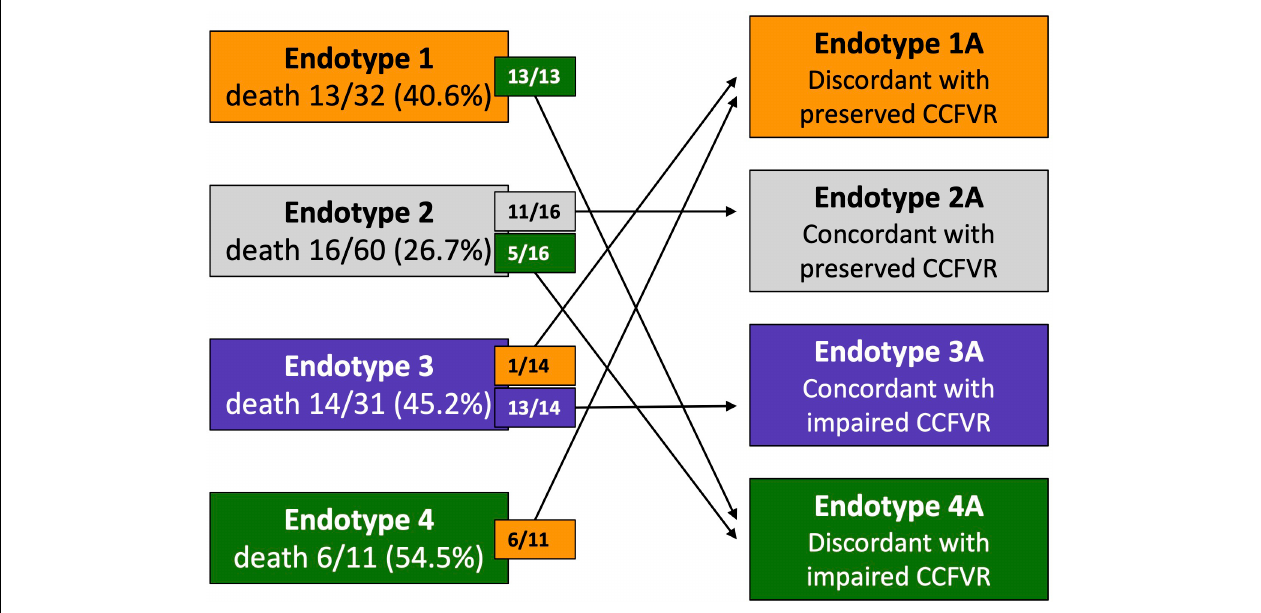
FIGURE 5 | Reclassification of HT patients on the basis of CCFVR which allows to further stratify mortality risk among HT patients. For example, endotype 1 has preserved CFVR but its mortality risk is comparable to endotype 3 (with impaired CFVR), making CFVR an incomplete predictor of mortality. If we reclassify patients using CCFVR, all the deaths of endotype 1 (preserved CFVR) are shifted to endotype 4A (preserved CFVR but impaired CCFVR). Interestingly, also 5 deaths from endotype 2 (also preserved CFVR) are assigned to endotype 4A using